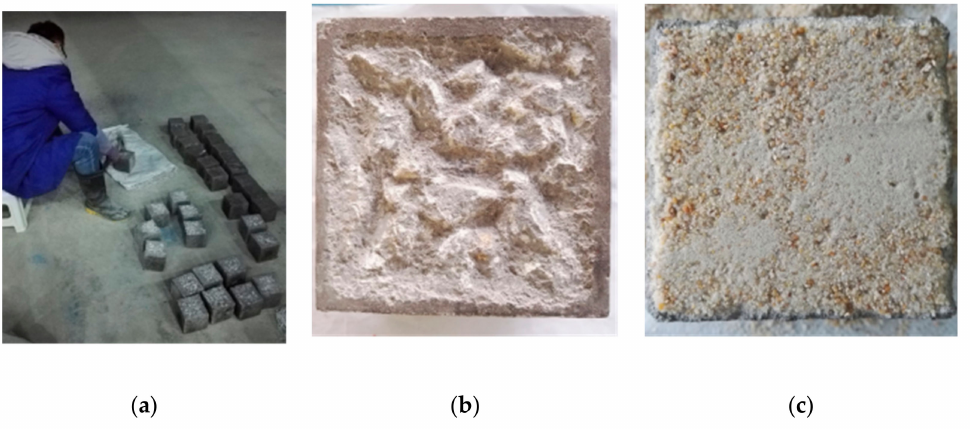
Figure 11. Rough-surface making and roughness measurement: ( a ) rough-surface making; ( b ) rough surface; and ( c ) sand filling.